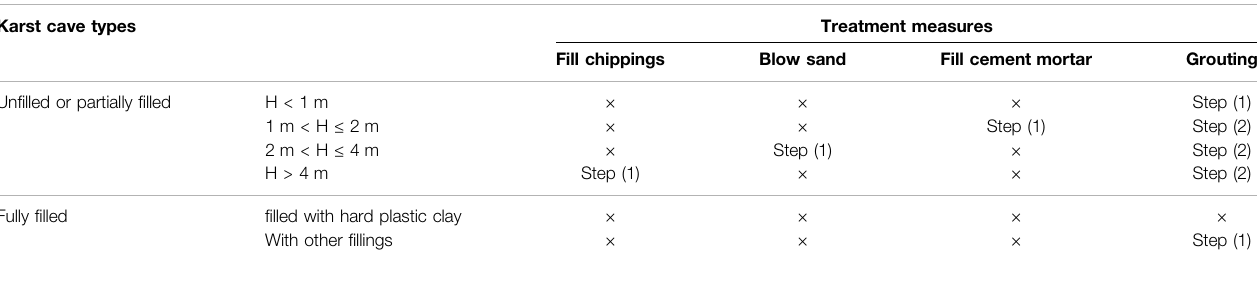
TABLE 1 | Treatment measures for different karst cave